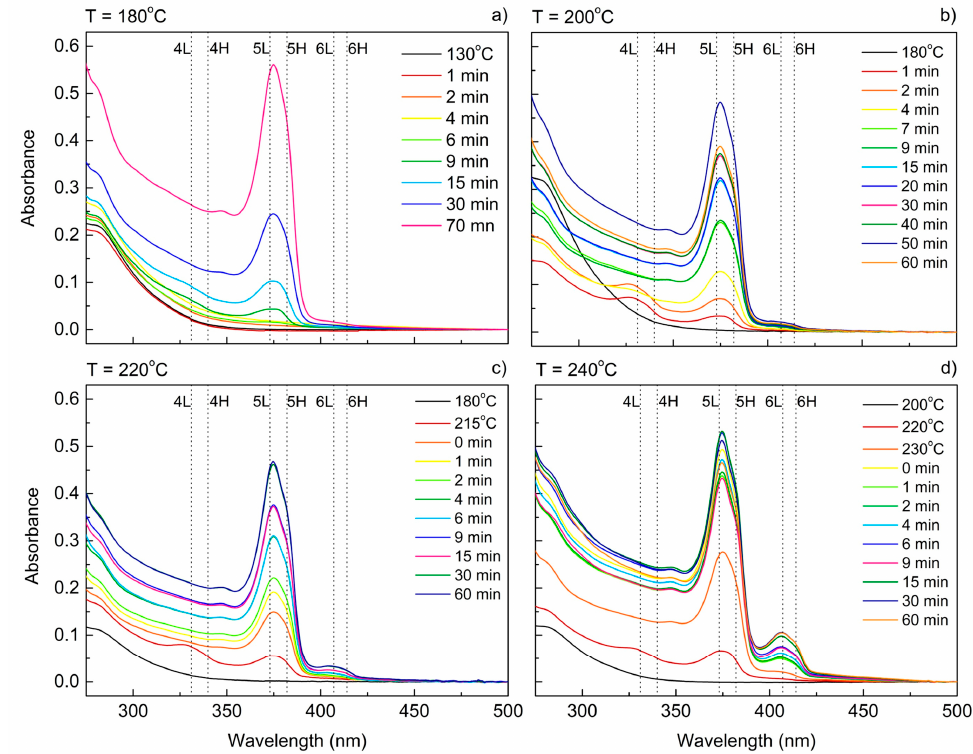
Figure 4. Absorbance spectra of CdS nanocrystals obtained with different reaction temperatures and 5 fixed Zn(Ac) 2 concentration recorded for aliquots taken at different stages of the reaction. The reaction temperature is indicated on top of every graph. The Zn:Cd ratio for all samples was 4:4. The electron- light hole (L) and electron-heavy hole (H) transitions for 4, 5, and 6 ML platelets are marked with dotted lines based on Reference [22]. The reaction temperatures are: ( a ) 180 ◦ C; ( b ) 200 ◦ C; ( c ) 220 ◦ C; ( d ) 240 ◦